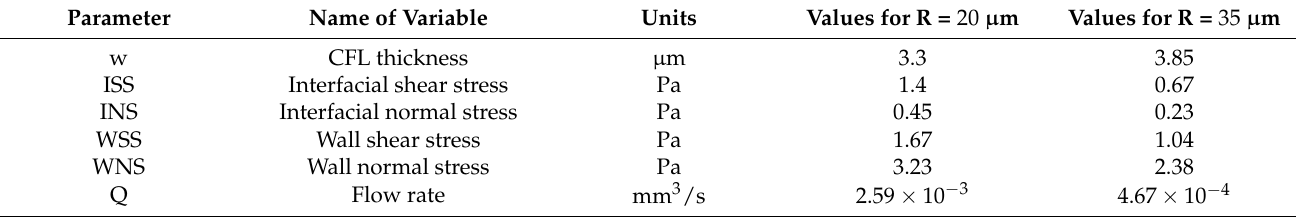
Table 4. Model predictions for CFL thickness (w), flow rate (Q), Interfacial Normal Stress (INS), Interfacial Shear Stresses (ISS), Wall Shear Stress (WSS), and Wall Normal Stress (WNS) for microtubes with a radius equal to 20 µ m and 35 µ m. Parameter Name of Variable Units Values for R = 20 µ m Values for R = 35 µ m w CFL